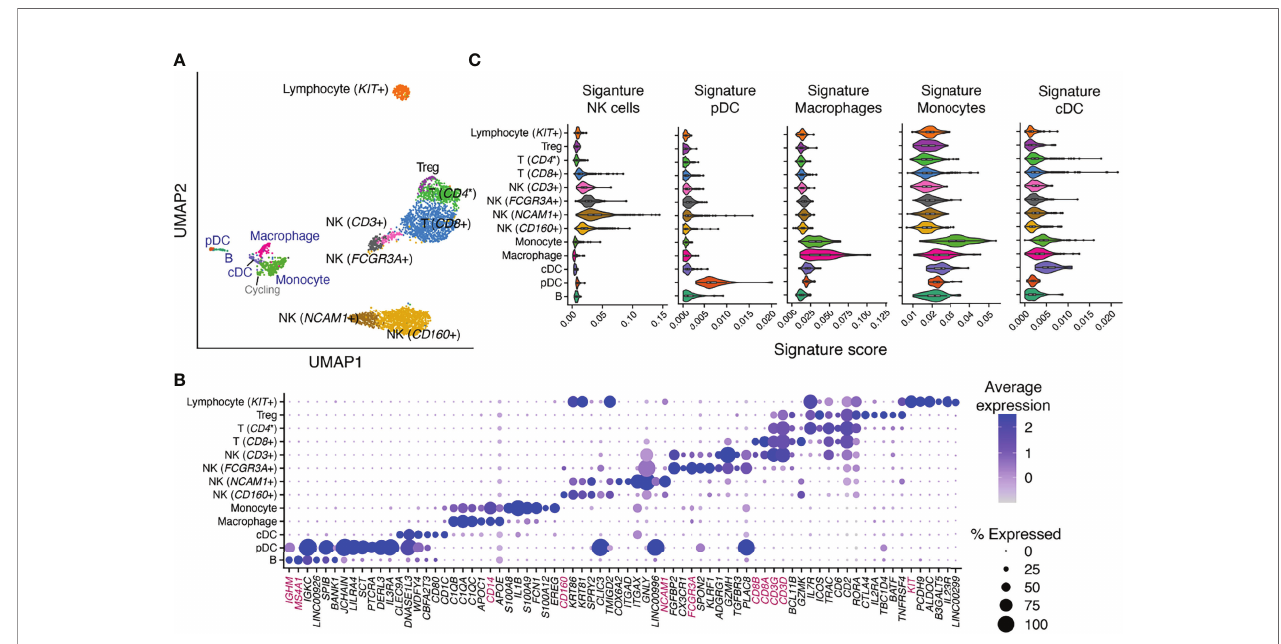
FIGURE 3 | Identi fi cation and annotation of 13 immune cell types/subtypes in healthy human endometrium. (A) Dimensional reduction and cluster identi fi cation of endometrial immune cells from women with no gynecological conditions and in natural menstrual cycles. In blue are cell types/subtypes that were from the “ Macrophage ” cluster and in black were from the “ Lymphocyte ” cluster in the original analysis. (B) Top uniquely expressed genes for identi fi ed cell types/subtypes in (A) . In magenta are classical cell-type markers. (C) Score distribution of selected immune signatures compiled from 6 data sources in each identi fi ed immune cell type/subtype. NK, natural killer cells; pDC, plasmacytoid dendritic cells; cDC, classical dendritic cells; CD4 *, CD4 was uniquely but sparsely expressed in the cell subtype [( Figure S8B ) and hence was not identi fi ed as a top uniquely expressed gene in (B)